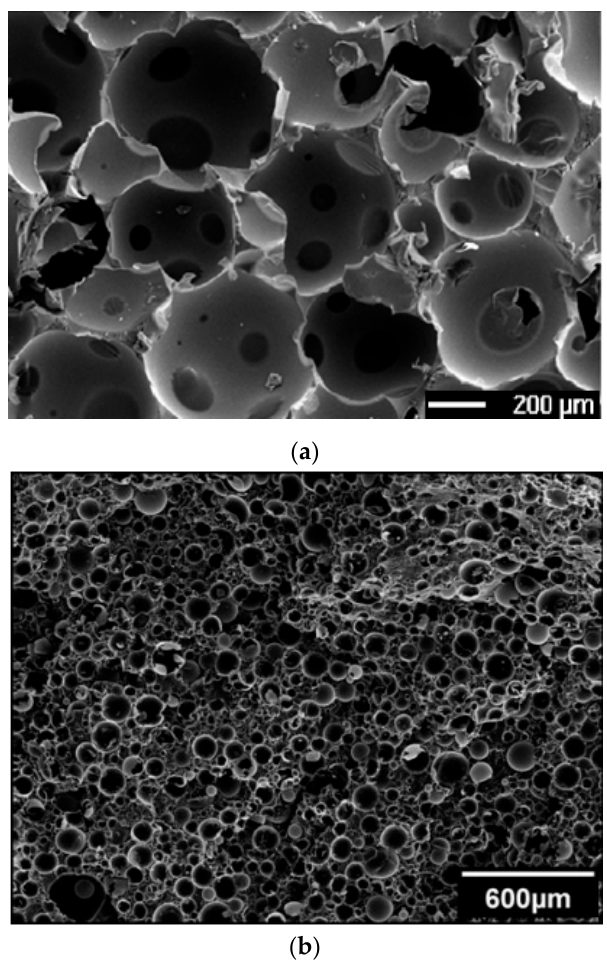
Figure 4. Scanning electron microscope (SEM) photographs of microstructures of shape memory polymer (SMP) foams: ( a ) the presence of voids in PU foams [49] and ( b ) the presence of voids and microspheres in Styrene foams [50].